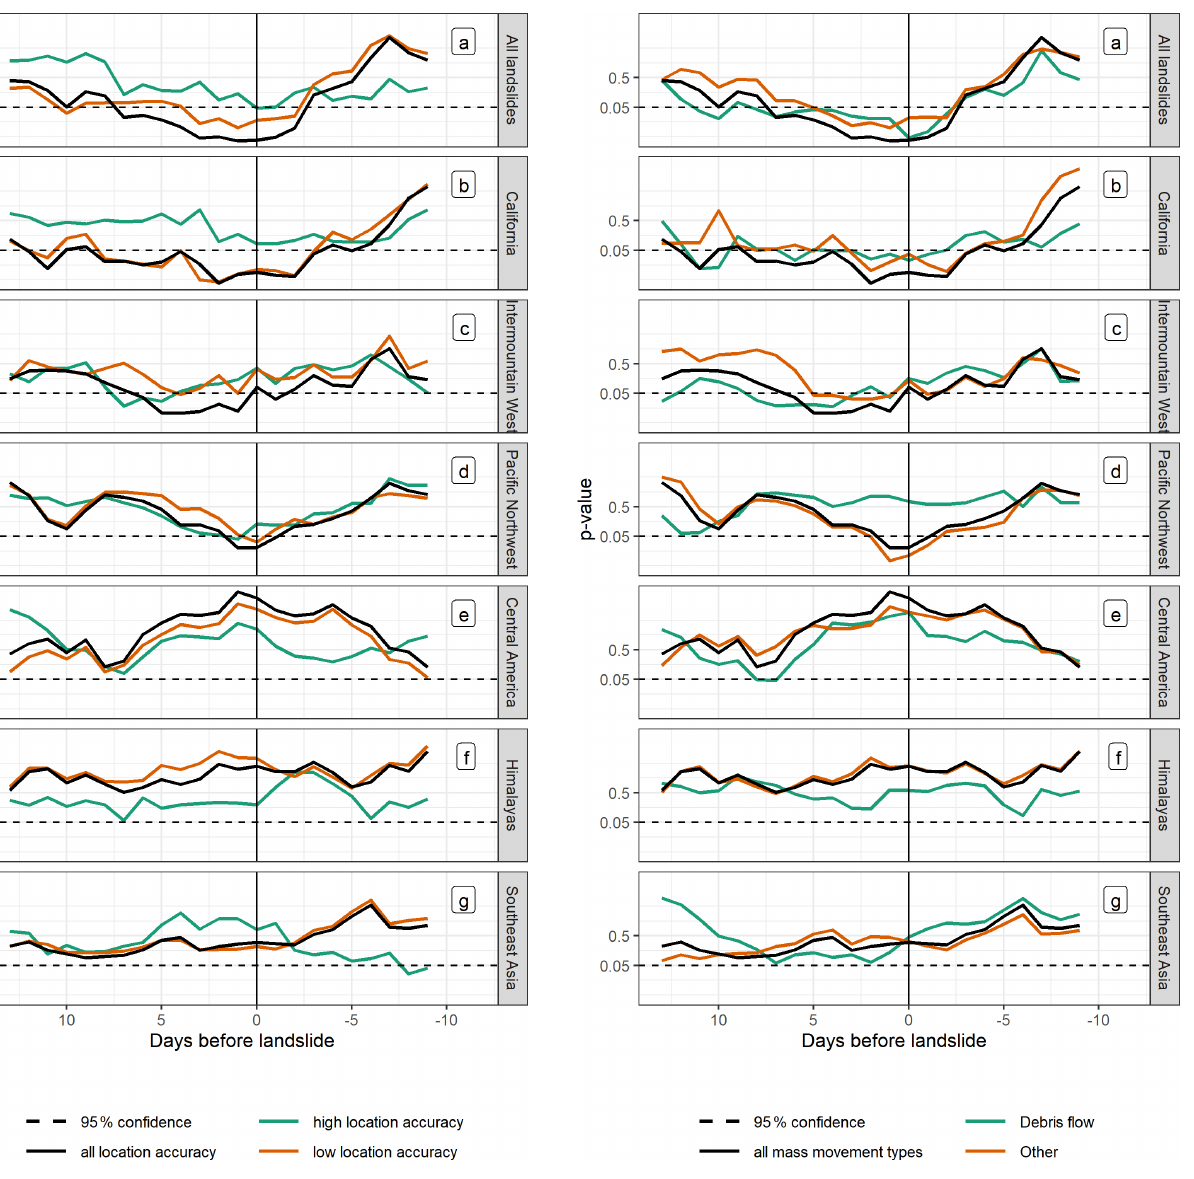
Figure 4. p values for Mann–Whitney hypothesis tests comparing precipitation percentiles at burned and unburned sites. The thick black line shows the p values for all mass movements, while green and orange lines show high (1km or less) and low (greater than 1km) location accuracies. A horizontal dashed black line shows the p = 0 . 05 significance threshold, while a vertical black line indicates the day of the event.